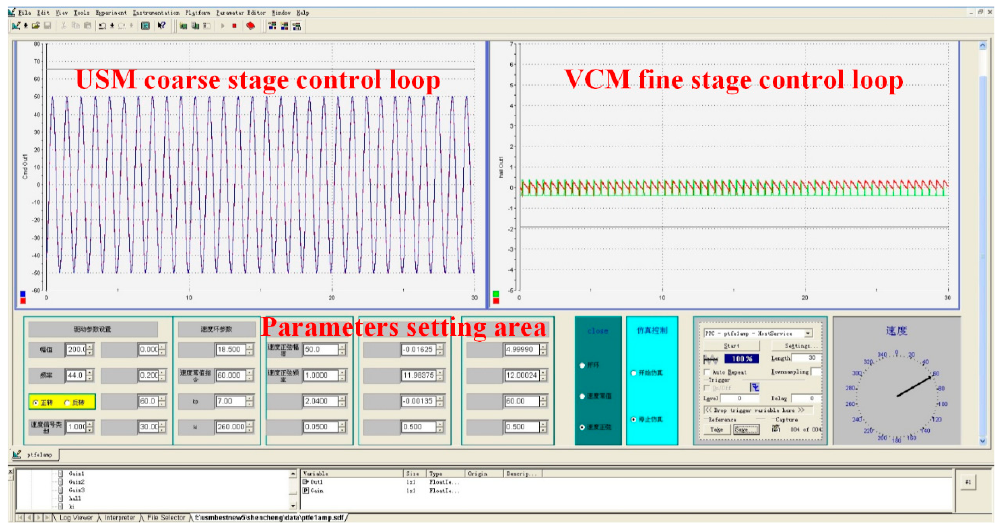
Figure 18. The USM-VCM coarse–fine composite mechatronic system control desk operating interface.